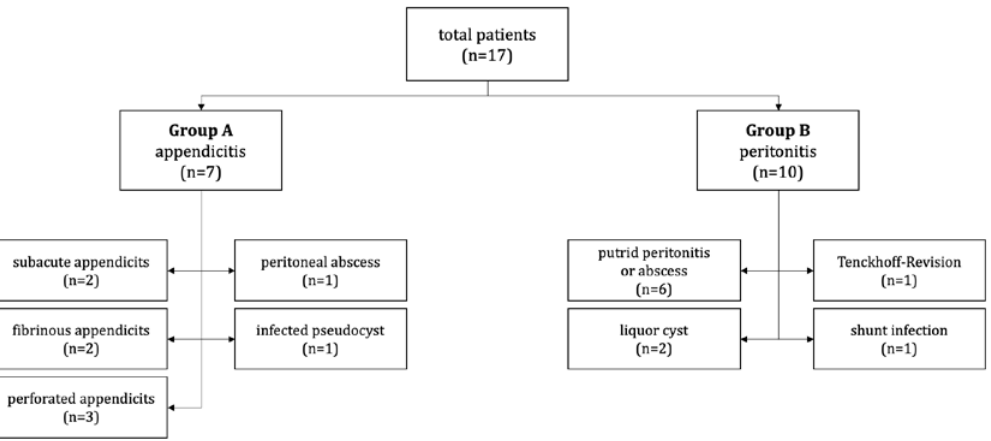
Figure 2. Overview of the surgical findings and reasons for acute abdomen in the patients included in this study.